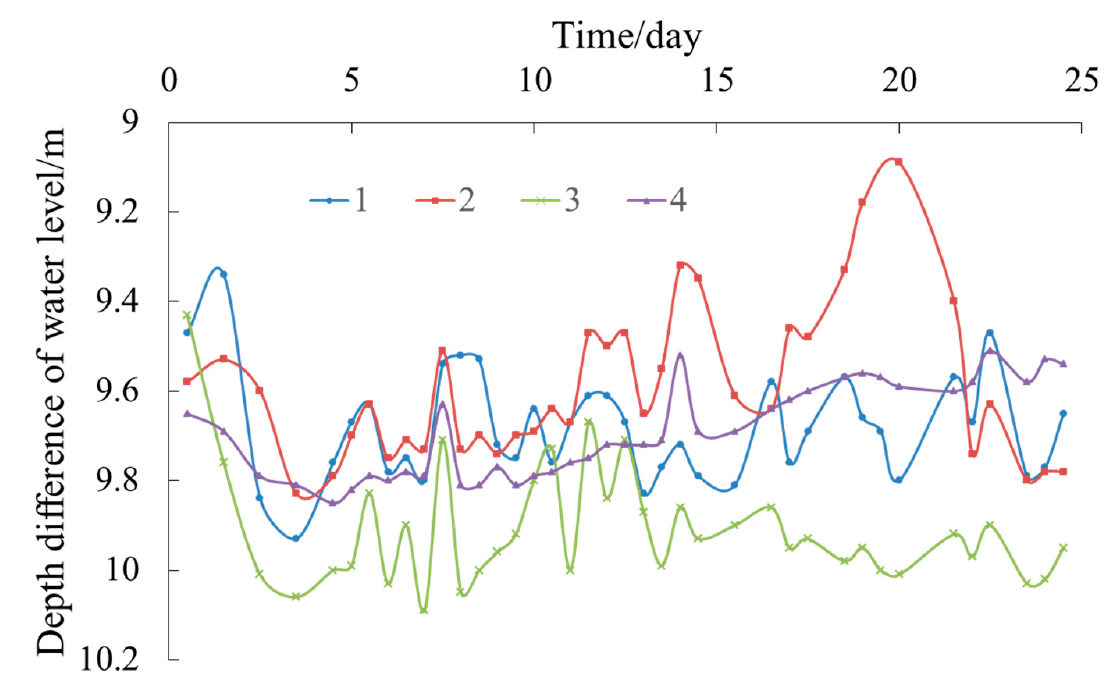
Figure 13. Depth drop of water level in siphon drainage holes.